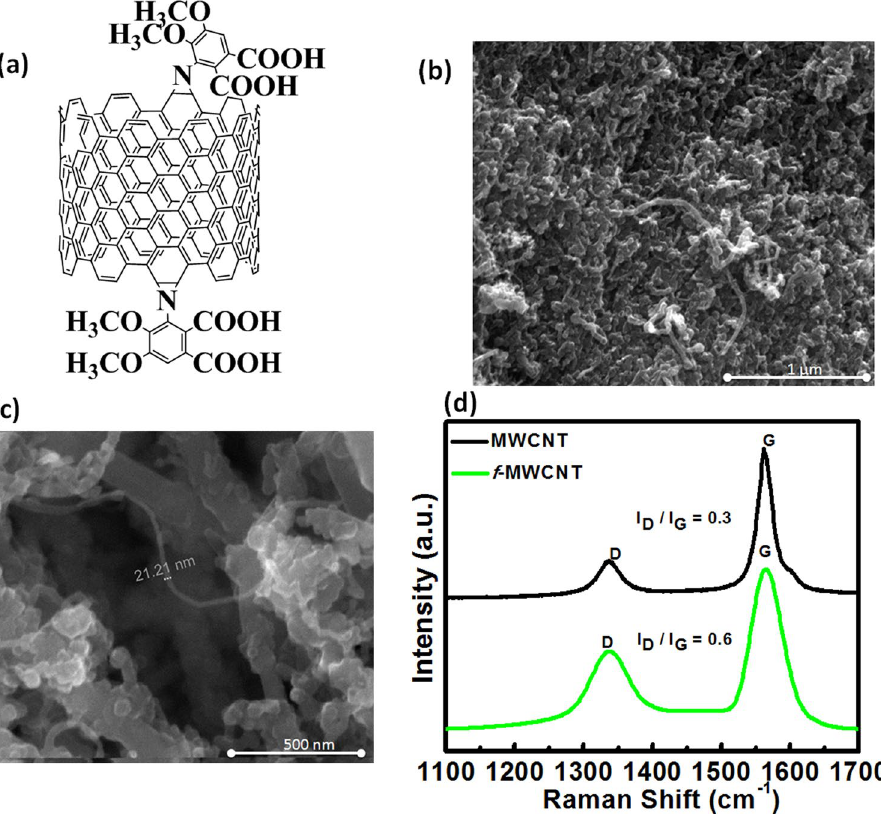
Figure 2. ( a ) Representation of the f-MWCNT structure; ( b ) SEM image of f-MWCNT from 1 µ m; ( c ) SEM image of f-MWCNT from 500 nm, reveals the diameter of f-MWCNT; ( d ) Raman spectra, MWCNT (black) and f-MWCNT